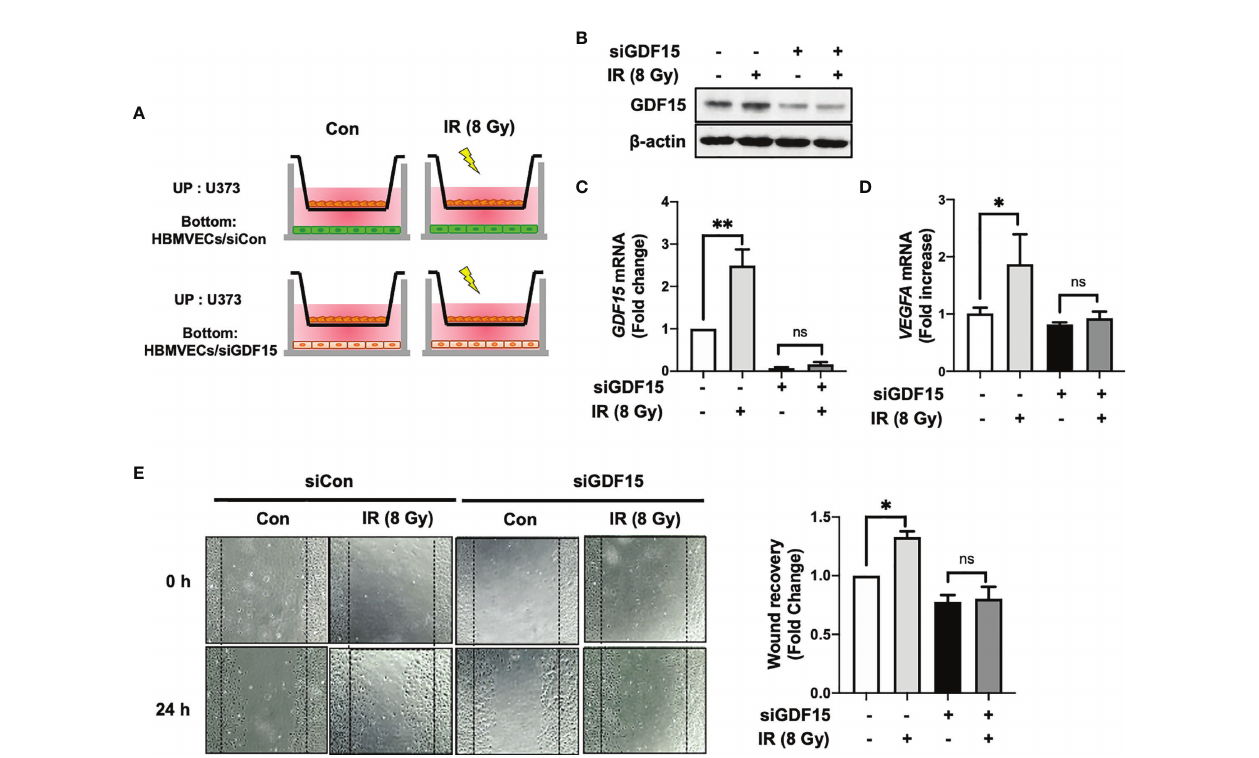
FIGURE 6 | GDF15 knockdown suppresses ionizing radiation (IR)-induced wound recovery. (A) Graphic experimental scheme; for the co-culture of U373 cells and human brain microvascular endothelial cells (HBMVECs), U373 cells were seeded on the upper well and the siGDF15-transfected or siCon-transfected HBMVECs were seeded on the bottom well. After irradiation with 8 Gy IR, U373 cells and HBMVECs were co-cultured for 24 h. (B) In HBMVECs, the protein levels of GDF15 were examined by immunoblotting analysis 24 h post-IR exposure. (C) In HBMVECs, the levels of GDF15 mRNA were determined using quantitative reverse transcription polymerase chain reaction 24 h post-IR exposure. (D) In U373 cells, the levels of VEGFA mRNA were determined using qRT-PCR 24 h post-IR exposure. (E) For the wound healing assay, the HBMVECs on the plate were scratched and incubated for 24 h after irradiation with 8 Gy IR. The wound recovery rates were assessed using ImageJ. Data are presented as the mean ± standard deviation of three experiments. * p < 0.05 and ** p < 0.01 compared with siCon-transfected and nonirradiated HBMVECs. ns, no signi fi